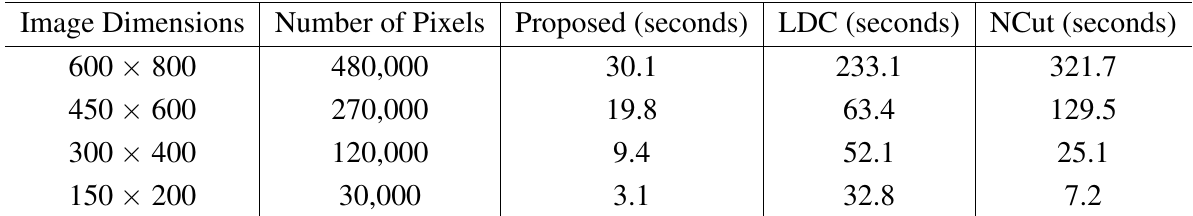
Table 2. Relation between time performance (in seconds), the dimension of the image, and the size in number of pixels, comparing the proposed method with LDC approach and Normalized Cuts